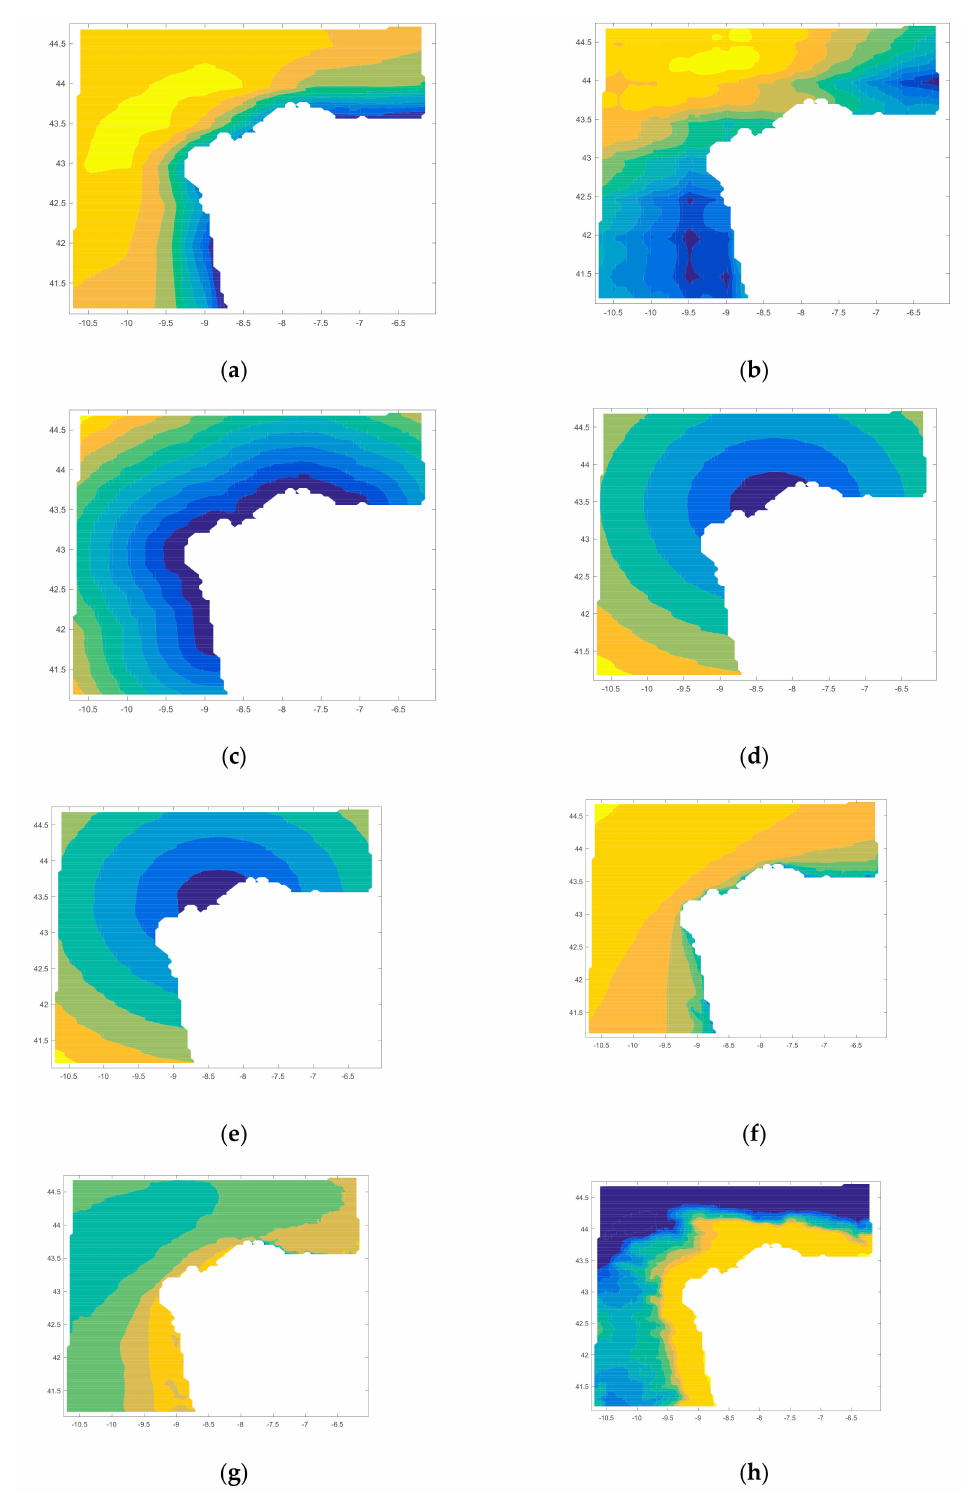
Figure 3. Map inputs: scale parameter of the o ff shore wind resource ( a ) in m / s, shape parameter of the o ff shore wind resource ( b ), distance from farm to shore in m ( c ), distance from farm to shipyard in m ( d ), distance from farm to port in m ( e ), height of waves in m ( f ), period of waves in s ( g ), and bathymetry in m ( h